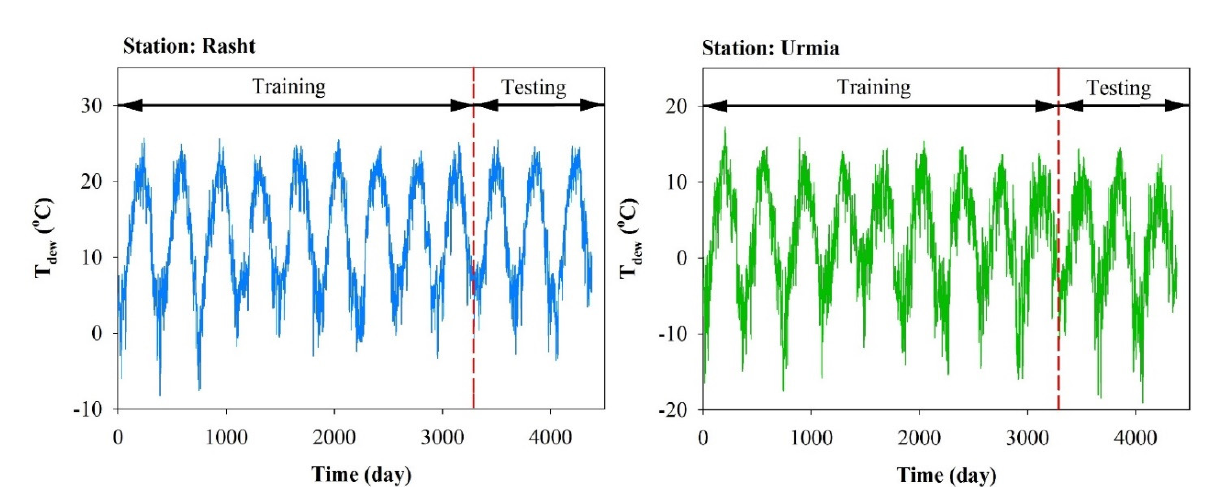
Figure 2. Time series graphs of the measured daily Tdew data for the studied locations during the training and testing periods.